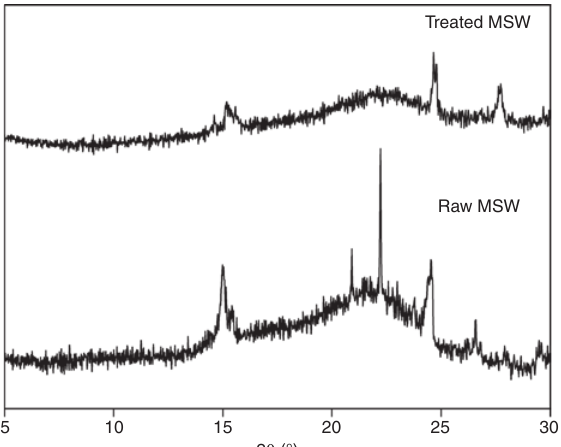
Figure 4 XRD of raw and treated MSW.